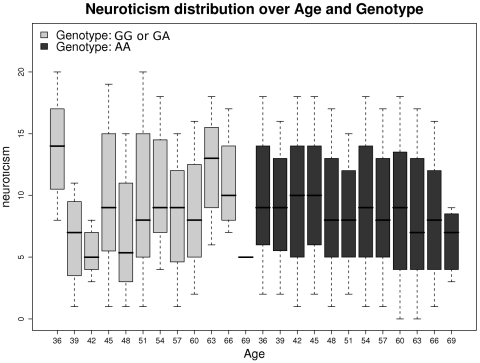
EPQ-N distribution by 3-year age groups according to minor allele carrier status at rs9561329.